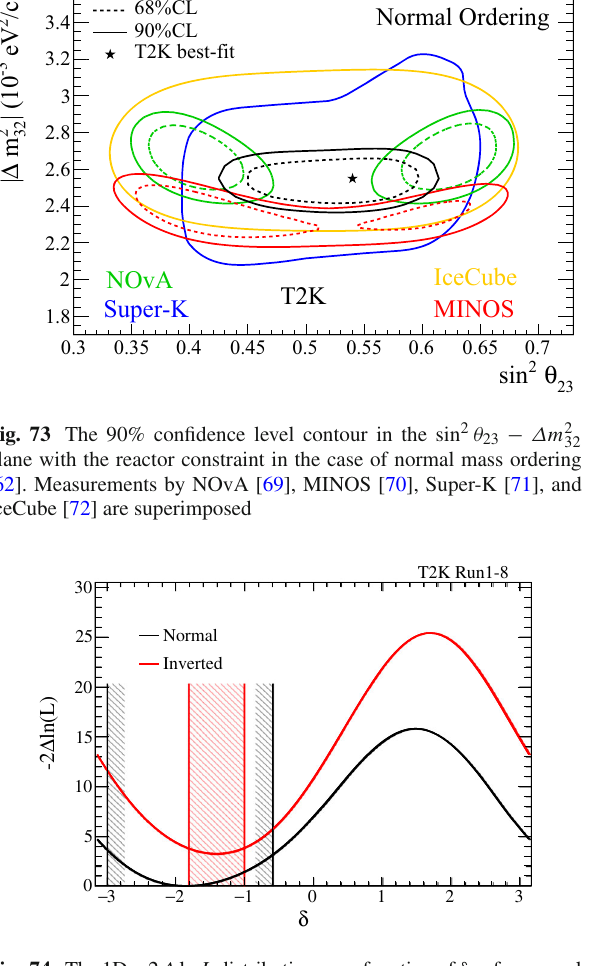
Fig. 74 The 1D − 2 Δ ln L distributions as a function of δ CP for normal (black) and inverted (red) mass ordering using the reactor θ 13 value in the PDG 2016 [67]. The vertical lines show the corresponding allowed 2 σ confidence intervals evaluated by the Feldman–Cousins method